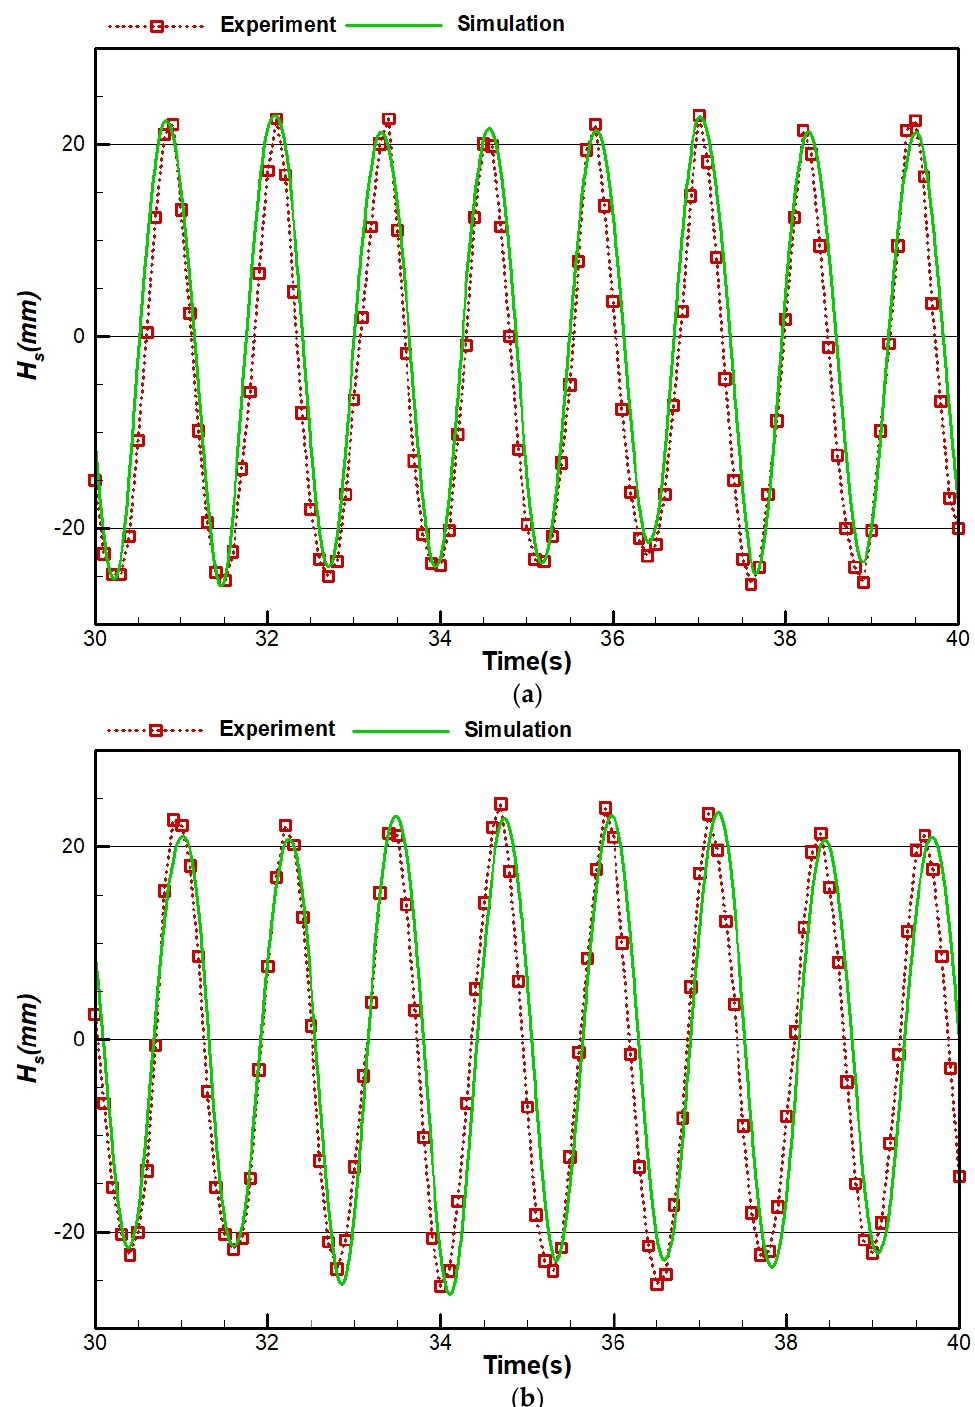
Figure 21. Wave height of case 4 at distances of ( a ) 3 m and ( b ) 5 m from the flap.